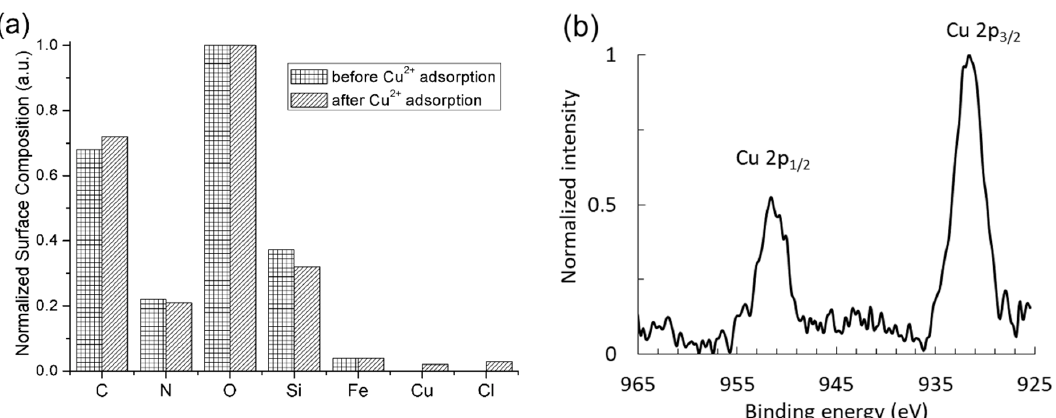
Figure 6. Normalized surface composition before and after Cu adsorption of MNPs@SiO 2 @GOPTS-bPEI (normalized to oxygen) is shown in ( a ) while the high-resolution core spectra for Cu 2p is shown in ( b ). The MNPs@SiO 2 @GOPTS-bPEI were used as a Cu adsorbent at optimal conditions, and Cu uptake